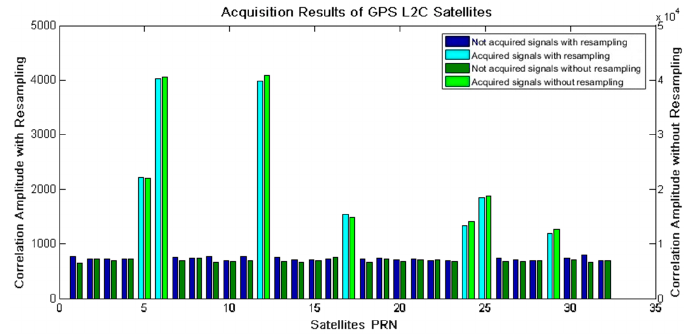
Figure 8. Acquisition results for GPS L2C satellites without/with the resampling strategy.